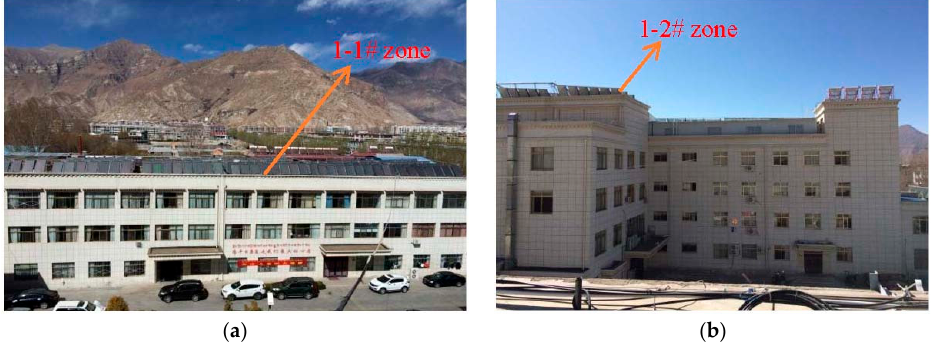
Figure 2. Solar collection zones: ( a ) 1-1# zone; ( b ) 1-2# zone.